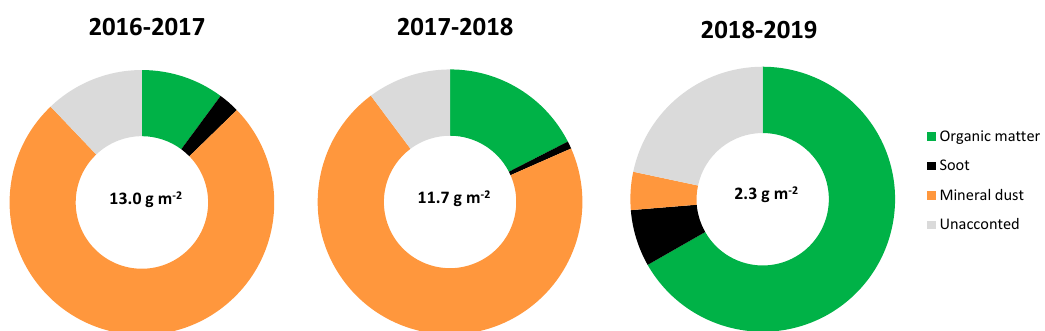
Figure 4. Chemical composition of the accumulated insoluble deposition during cold-seasons (from beginning of November to end May) at ORD (Central Pyrenees, Spain), in g m − 2 .